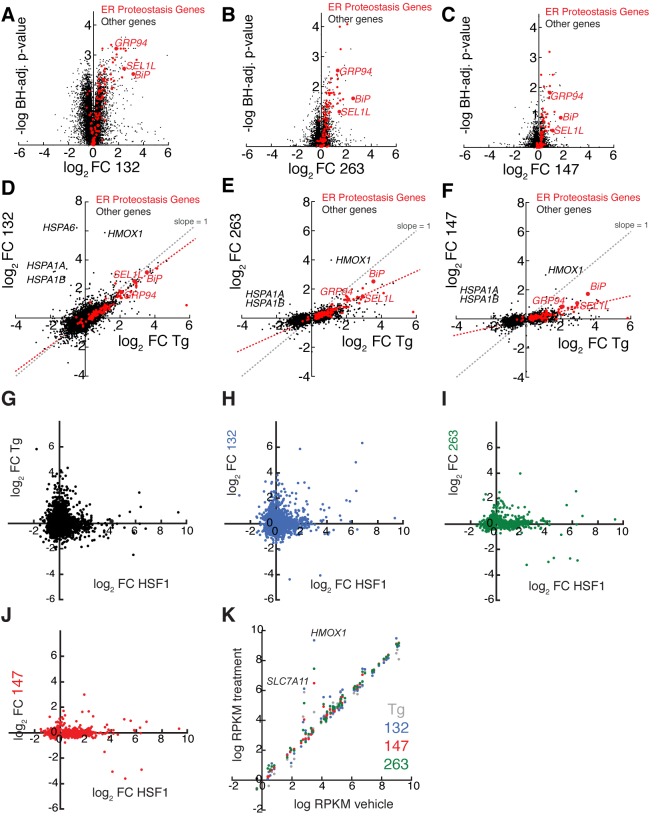
mRNA-Seq analysis shows that ER proteostasis regulators do not globally activate the Heat Shock Response (HSR) or oxidative stress response pathways.(A–C) Volcano plots showing log2 mRNA fold-change (FC, relative to vehicle-treated controls) versus -log10 Benjamini Hochberg (BH) adjusted p-value for mRNAs in HEK293T-Rex cells treated with small molecule ER proteostasis regulators 132 (A), 263 (B) or 147 (C) (all treated at 10 µM, 6 hr). The red symbols represent ER proteostasis factors as identified in the Source Data. The ATF6-regulated ER proteostasis genes BiP, GRP94, and SEL1L are highlighted. (D–F) Correlation of log2 mRNA fold change (FC) with Tg (1 µM; 6 hr; relative to vehicle-treated control) versus log2 mRNA FC with small molecule ER proteostasis regulators 132 (D), 263 (E) or 147 (F) in HEK293T-Rex cells (treated as indicated above). All genes displaying a significant change (BH adjusted p-value < 0.1) for Tg-treatment or treatment with small molecule ER proteostasis regulators are shown. The red symbols represent ER proteostasis factors, as identified in the Source Data. The gray dashed line reflects levels of gene induction observed following Tg-induced ER stress (slope = 1). The red dashed line corresponds to a least squares linear regression that reflects the induction of ER proteostasis gene induction observed following treatment with the indicated small molecule ER proteostasis regulator. Treatment with 132 (D) shows a clear correlation with Tg treatment indicating global UPR activation, while 263 (E) and 147 (F) do not globally increase transcription of Tg-regulated genes and show lower levels of select ER proteostasis gene induction. The ATF6-regulated ER proteostasis genes BiP, GRP94, and SEL1L are highlighted. G–J. Plot showing the log2 transcript fold change with Shield-1-dependent FKBP-HSF1 activation in HEK293T-Rex cells stably expressing FKBP-HSF1 (mRNA-seq analysis) (Ryno et al., 2014) versus log2 mRNA fold change with Tg (G) or small molecule ER proteostasis regulators 132 (H), 263 (I), or 147 (J) in HEK293T-Rex cells. The FKBP-HSF1 fusion protein is activated by the addition of the pharmacologic chaperone Shield-1, which stabilizes the active FKBP-HSF1 protein and promotes HSF1 transcriptional activity (Ryno et al., 2014). All gene expression data used in this analysis are included in the Source Data. Only genes whose expression is significantly altered (FDR < 0.1) by FKBP-HSF1 activation in HEK293T-Rex cells are shown. (K) Plot comparing the expression of oxidative stress target genes in HEK293T-Rex cells treated with vehicle or Tg (1 µM; grey), 132 (10 µM; blue), 147 (10 µM; red) or 263 (10 µM; green). The data are presented as log reads per kilobase million (RPKM) of vehicle versus log RPKM for the indicated treatment using the data from our mRNA-seq analysis. Genes that fall on the diagonal are not induced by small molecule treatment. Oxidative stress genes were selected from the SABIOsciences Oxidative Stress PCR Array.DOI:
http://dx.doi.org/10.7554/eLife.15550.01210.7554/eLife.15550.013Figure 3—figure supplement 1—source data 1.Excel spreadsheet describing the RNA-seq data used to prepare Figure 3—figure supplement 1A–K.This spreadsheet contains 4 tabs including a Table of Contents, RNA-seq FC Tg 132 147 263 ATF6, HSF1 genes, and oxidative stress genes.